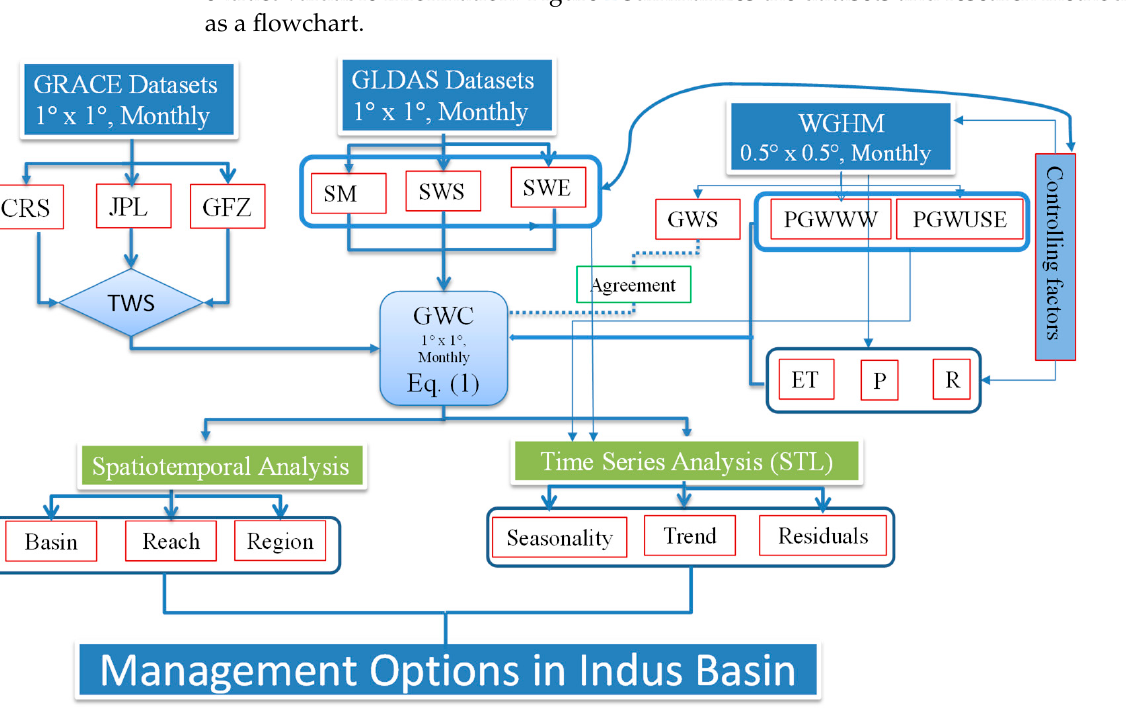
Figure 2. Flowchart of the datasets used and analyses performed.